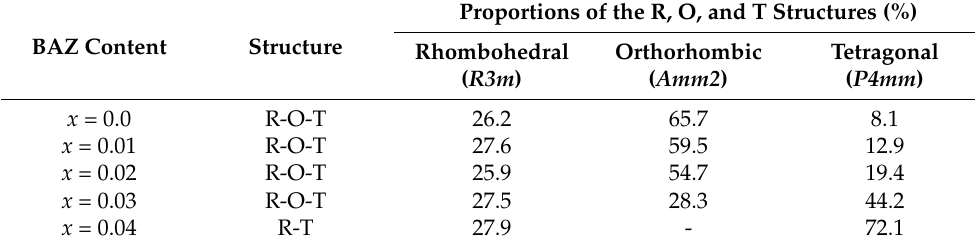
Table 3. Proportions of the R, O, and T structures in the textured NKNS-(0.04 − x)SZ-xBAZ thick